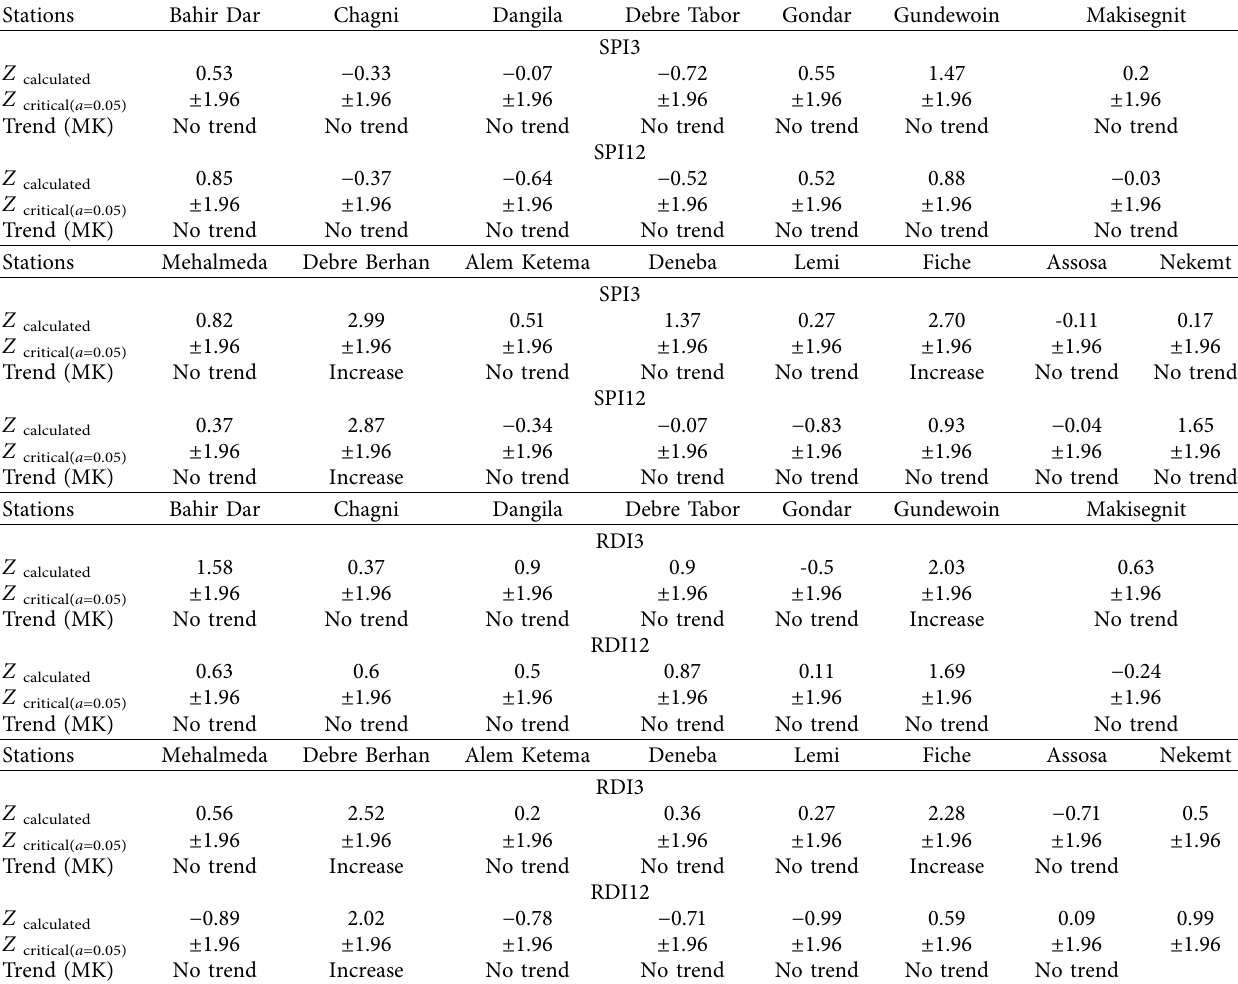
Table 7: Result of Mann–Kendall (MK) test for SPI3, SPI12, RDI3, and RDI12.